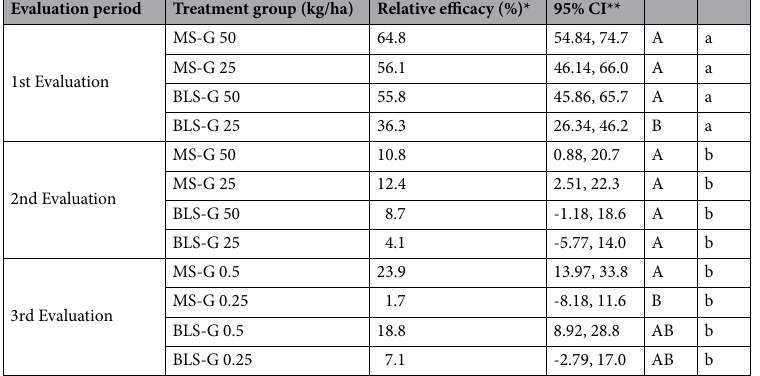
Table 2. Relative efficacy (%) of tick control obtained in three evaluations periods after exposure of Rhipicephalus microplus population to soil treatment with 25 or 50 kg/ha of granular formulations containing